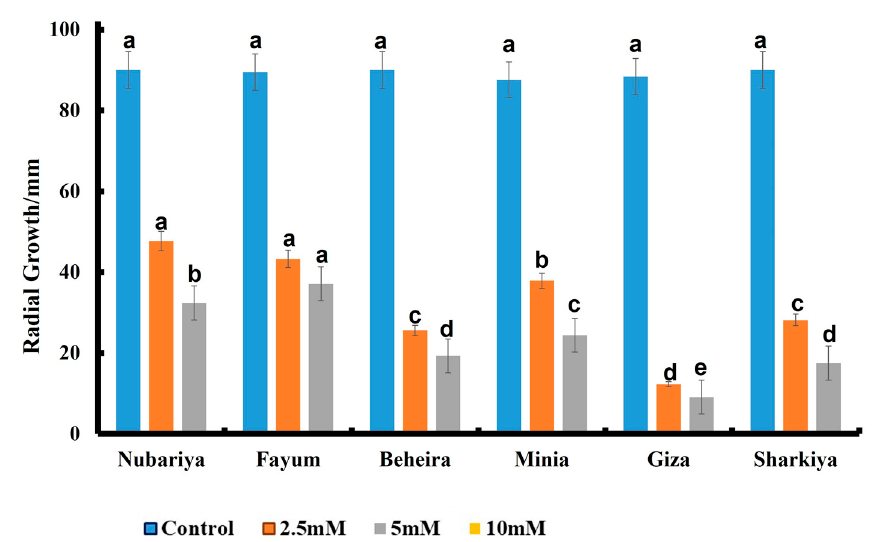
Figure 6. Effect of different concentrations (2.5, 5 and 10 mM) of chitosan on the growth of H. maydis isolates from different origin sites at 7 days post-inoculation. All values are presented as a mean of five replicates + SE . a,b,c,d Estimates with the same letters are not significantly different ( p ˂ 0.05) among different isolate sources (governorates) for the same concentration.